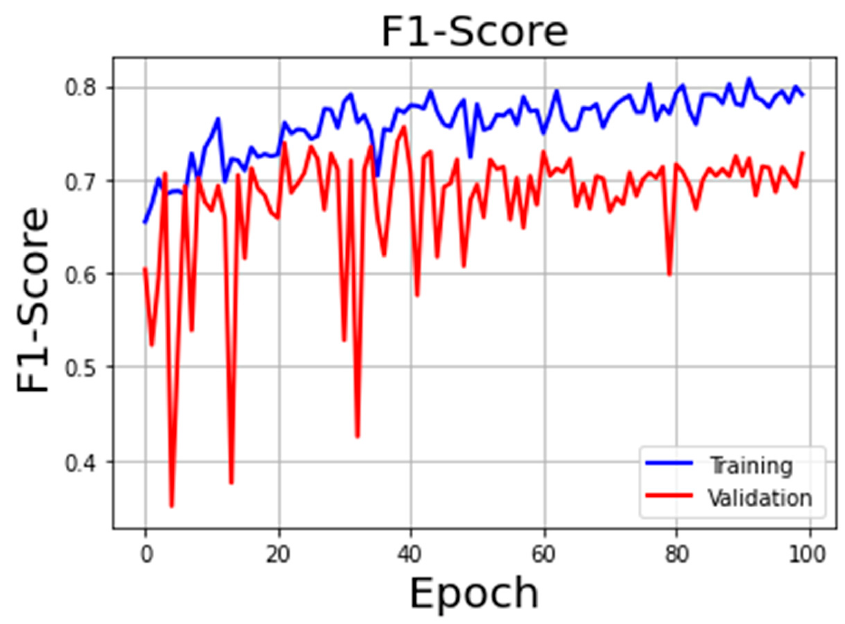
Figure 9. F1-Score during training and validation using IoU-based Loss.